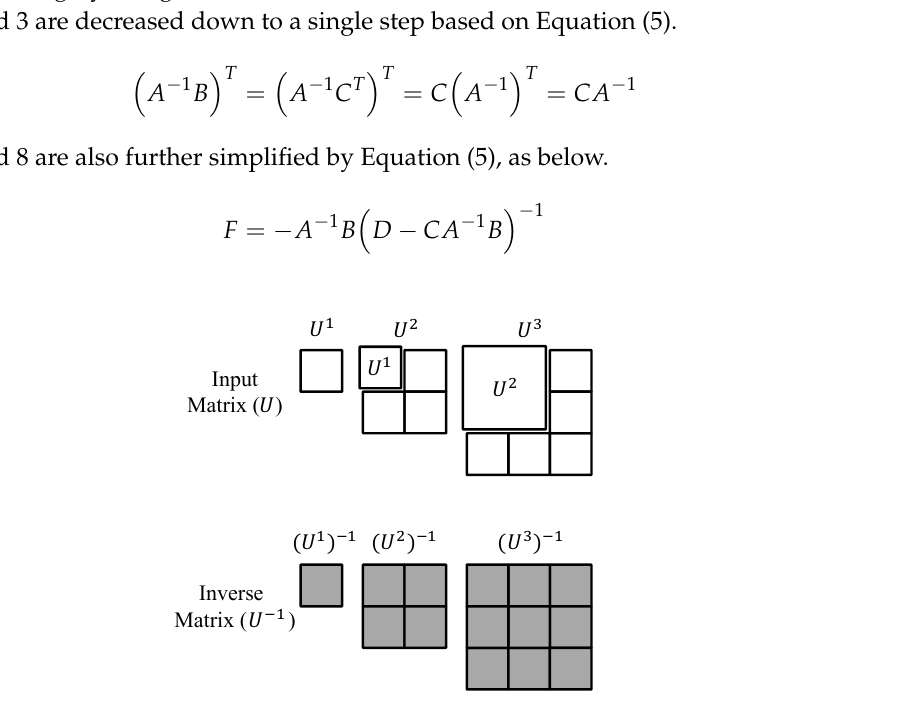
Figure 1. Reduction of computation complexity by copying the inverse matrix from previous iteration.